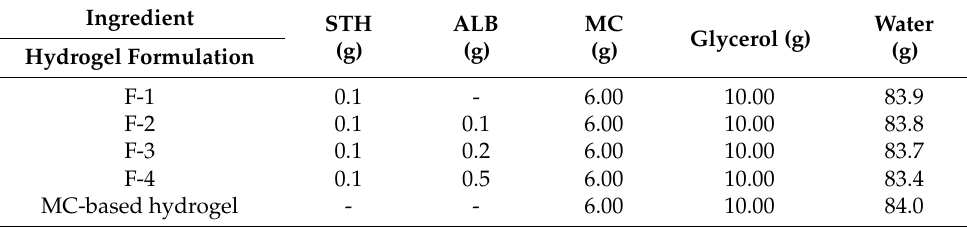
Table 1. Composition of prepared hydrogel formulations’ ingredients per 100.0 g of